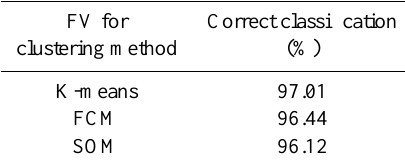
Table 4. The classification percentages obtained for each FV.